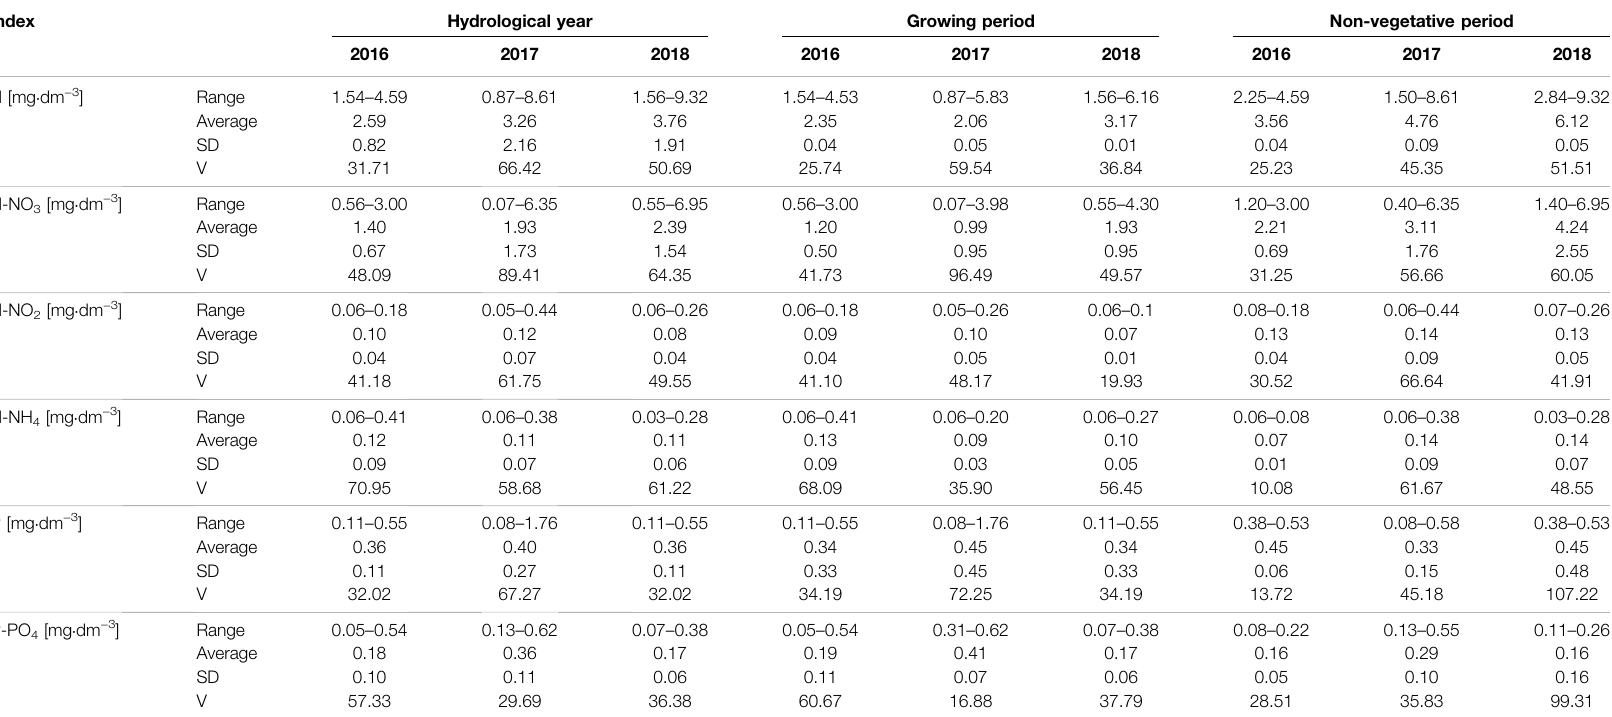
TABLE 2 | Water quality indicators of the G ł uszynka river during the hydrological years 2016 – 2018, broken down into growing and non-vegetative